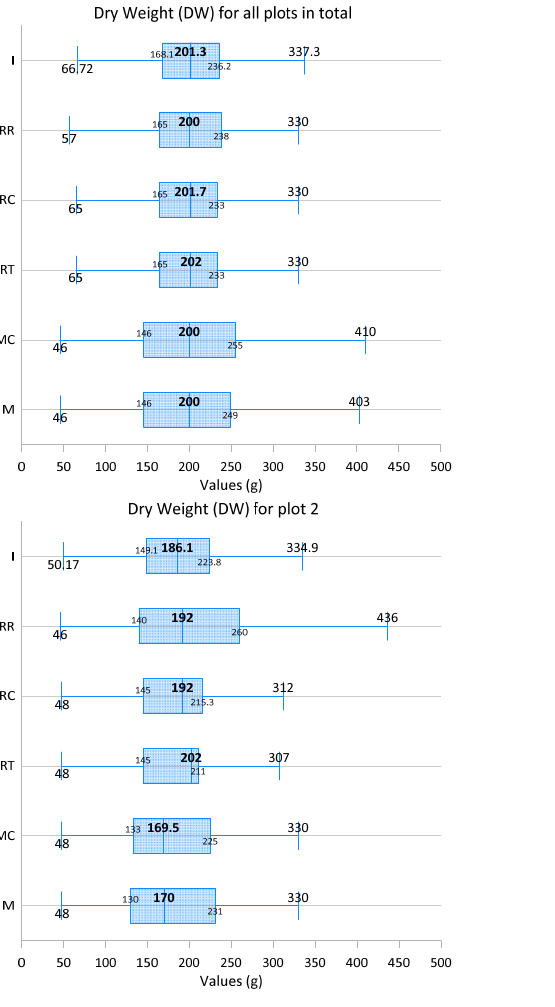
Figure 5. Dry weight (DW) descriptive statistics for the different sampling methods: M: Measured (all data); MC: Measured cut (without the measurements from the upper part area—lines 20 to 25); RT: Missing values were replaced by the total average of all values; RC: Missing values were replaced by the average of the column, where the missing value belongs to; RR: Missing values were replaced by the average of the row, where the missing value belongs to; I: Interpolation.